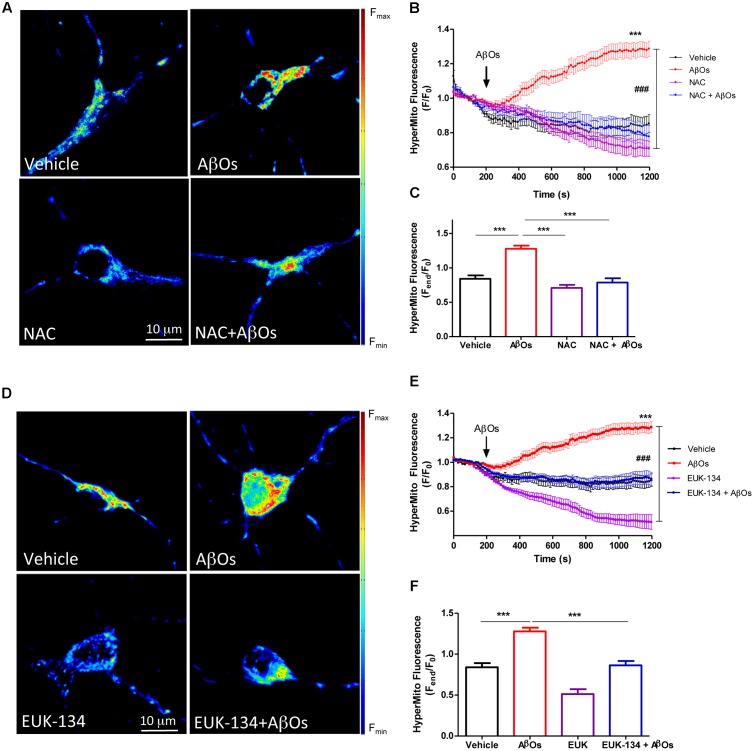
The antioxidants NAC and EUK-134 prevent mitochondrial H2O2 generation induced by AβOs.(A) Hippocampal neurons transfected with the plasmid HyperMito were pre-incubated with 10 mM NAC for 30 min and were then treated with 500 nM AβOs or kept in vehicle at the microscope stage. Pseudocolor images of HyperMito fluorescence in confocal sections obtained at the end of the experiment (1200 s). The scale bar corresponds to 10 μm. In the pseudo color rainbow scale (right), “warmer” colors correspond to higher fluorescence. (B) HyperMito fluorescence recorded as a function of time in neurons kept in vehicle (black trace), in neurons treated with AβOs (red trace), in neurons pre-incubated with EUK-134 and kept in vehicle (pink trace) or treated with AβOs (blue trace). Changes in fluorescence, plotted as signal over time with respect to the baseline fluorescence (F/F0), were expressed as mean ± SE. (C) Changes in HyperMito fluorescence were plotted as the signal obtained at the end of the experiment (1500 s) with respect to the baseline fluorescence (Fend/F0) and expressed as the mean + SE, for all the experimental conditions. (D) Neurons were transfected with the plasmid HyperMito, pre-incubated with 20 μM EUK-134 for 2 h and treated with 500 nM AβOs or vehicle at the microscope stage. Pseudocolor images of HyperMito fluorescence obtained were obtained as in (A). (E) HyperMito fluorescence recorded as a function of time in neurons kept in vehicle (black trace), in neurons treated with AβOs (red trace), in neurons pre-incubated with EUK-134 and kept in vehicle (pink trace) or treated with AβOs (blue trace). Changes in fluorescence were plotted as signal over time with respect to the baseline fluorescence (F1/F0) and expressed as mean ± SE. Arrow indicates the time of AβOs additions. (F) Changes in HyperMito fluorescence were plotted as the signal obtained at the end of the experiment (1500 s) with respect to the baseline fluorescence (Fend/F0) and expressed as the mean + SE, for all the experimental conditions. For each condition, ROIs were defined in 1 to 3 neurons per field in order to monitor the production of hydrogen peroxide levels. The experiments were repeated in triplicate using at least in three different cultures (n = 24 for Control, n = 36 for AβOs, n = 12 for NAC + AβOs, n = 12 for NAC, n = 16 for EUK-134 + AβOs, n = 32 for EUK-134). Statistical analysis was performed using one-way ANOVA followed by Bonferroni post hoc test. ∗∗∗p < 0.001 compared with control. ###p < 0.001 compared to AβOs.